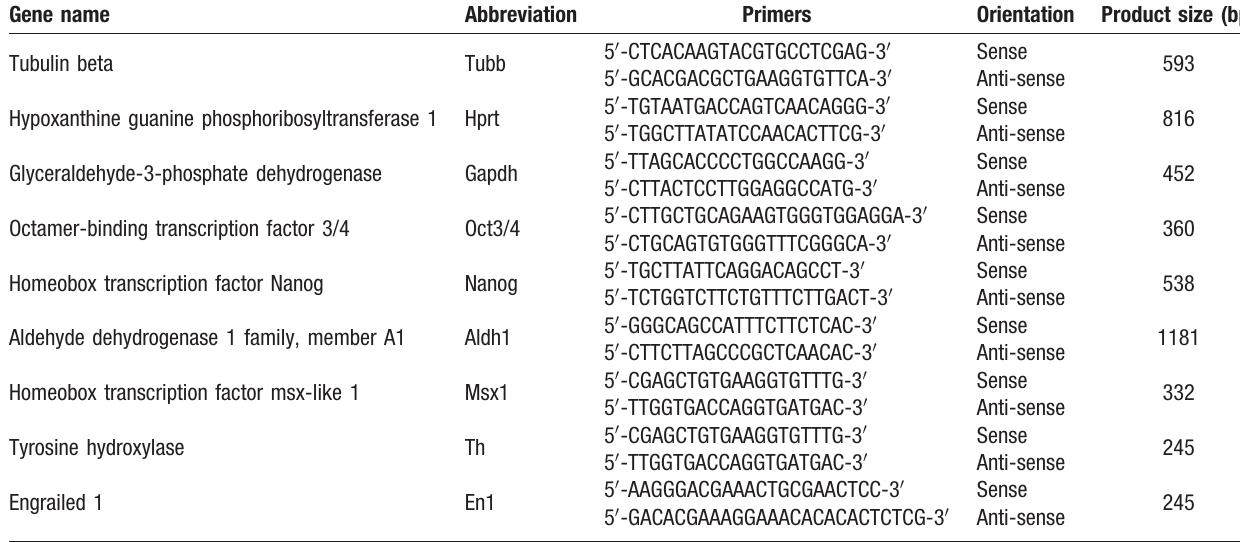
Table 1. List of primers used in this